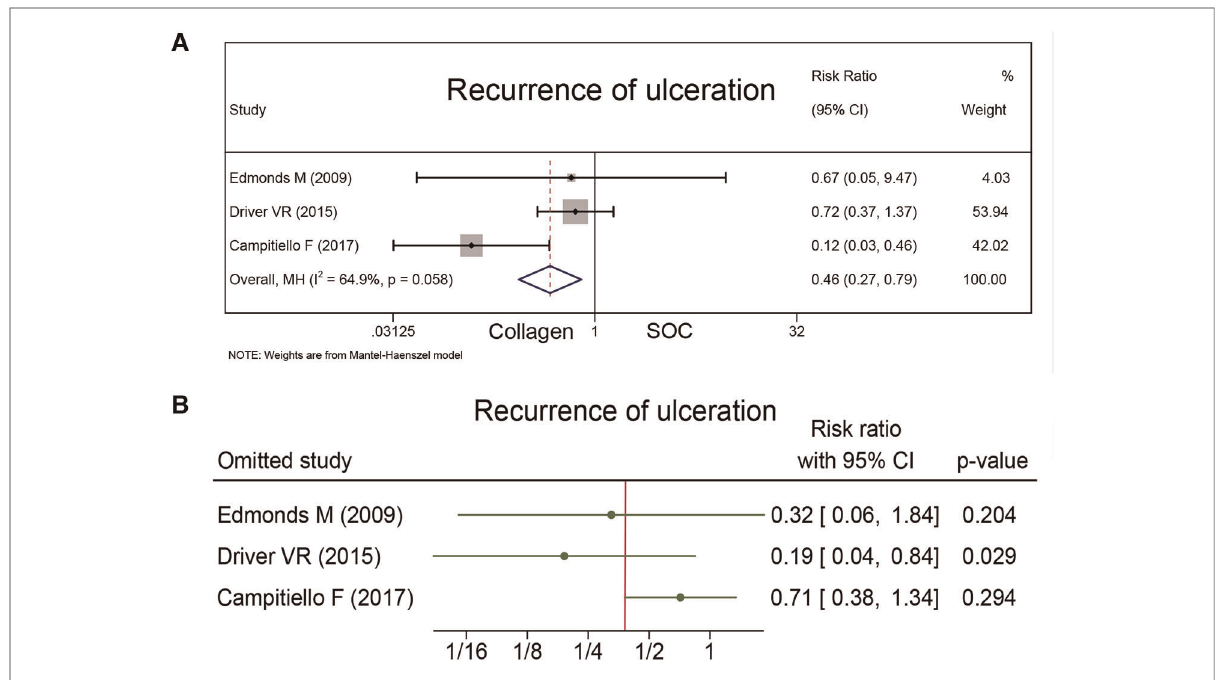
FIGURE 6 Recurrence of ulceration: ( A ) the pooled result; ( B ) sensitivity